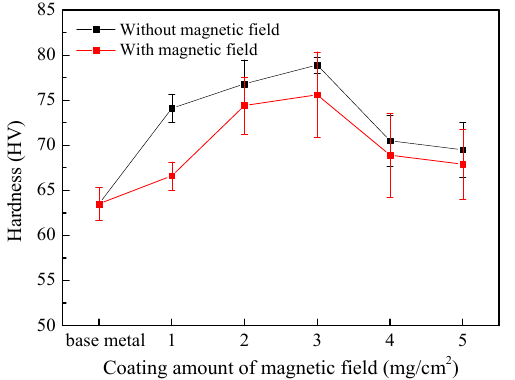
Figure 10. Hardness of weld metal and BM.